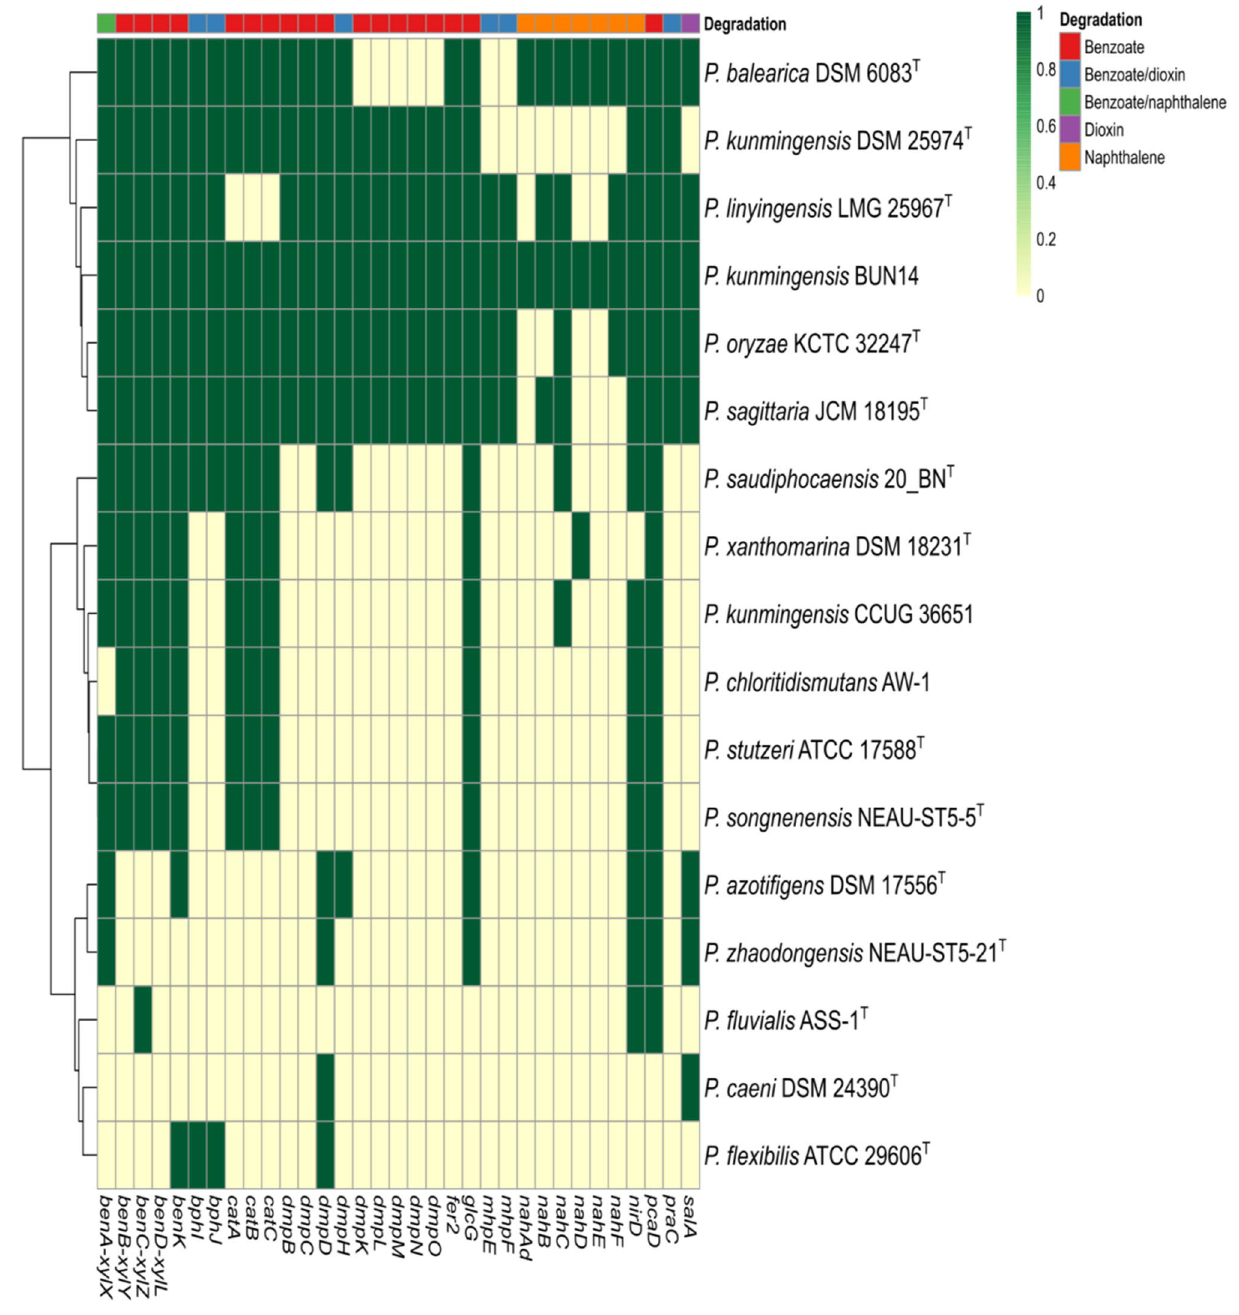
Figure 5. Heat map showing the distribution of orthologous proteins of strain BUN14 and closely related species, associated benzoate, dioxin and naphthalene degradation pathways. The heat map was based on the presence/absence matrix of orthologous proteins determined using Orthofinder. Heat map was produced using Clustvis version 1 (https:// biit. cs. ut. ee/ clust